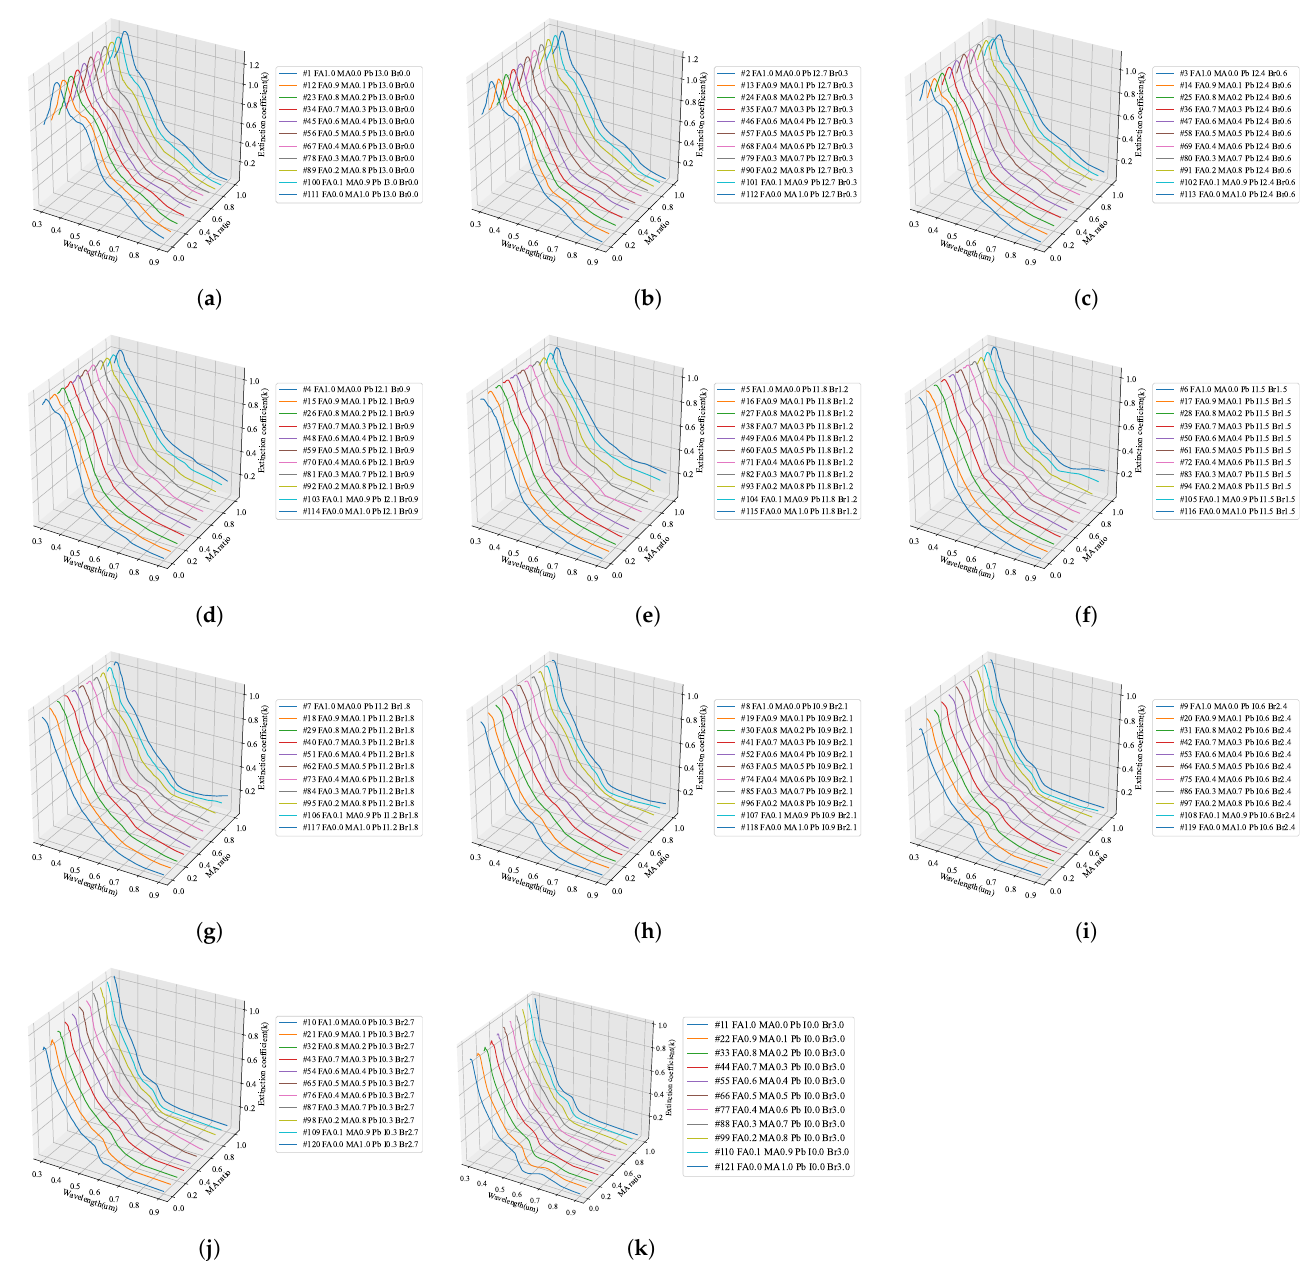
Figure 11. Prediction result of the extinction coefficient spectrum pattern according to the stoi- chiometric ratio in the direction of increasing MA composition of quaternary perovskite using hy- perregression analysis with artificial intelligence: ( a ) FA 1